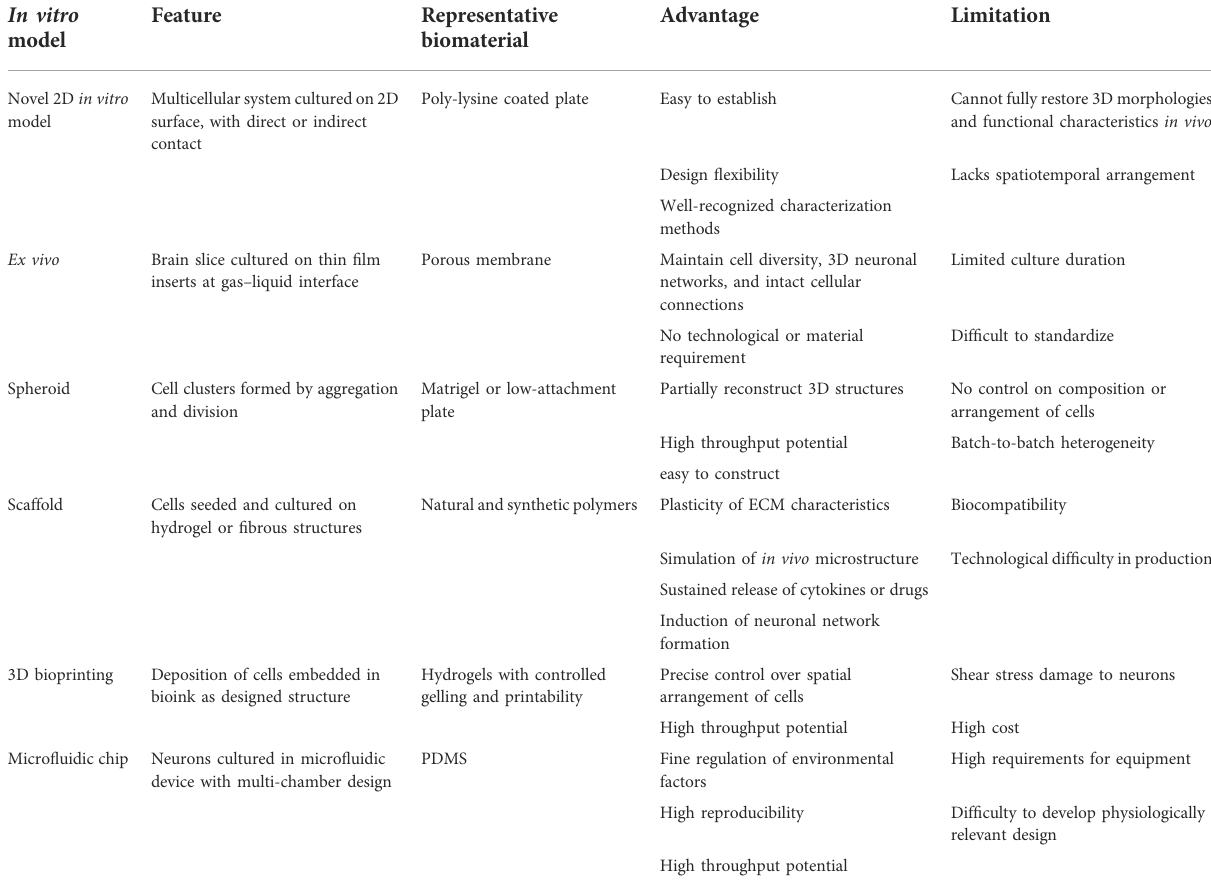
TABLE 1 Overview of in vitro model of primary neurons, with their features, advantages, and limitations. In